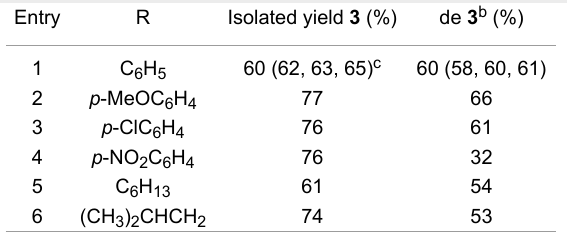
Table 3: Asymmetric aza-Diels-Alder reaction of diene 1 with different imines 2 . Conditions a : imine 2 :diene 1 :IL 4 (X = OH, R' = C 8 H 17 , Y = OTf) = 1:1.5:2; temperature: 30°C; time: 4.30 h